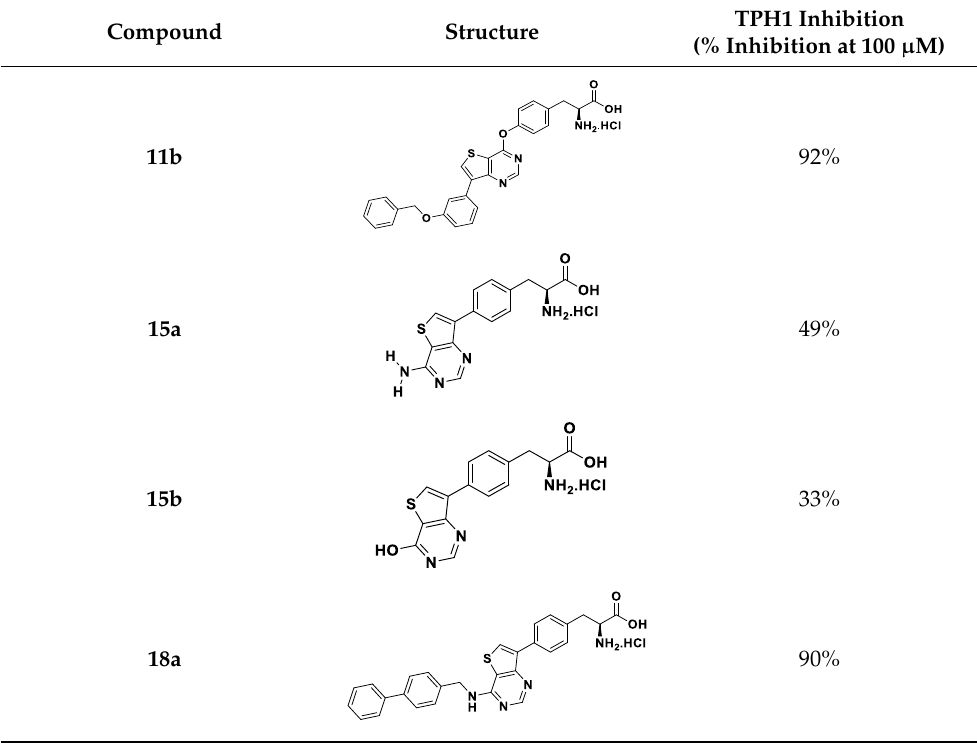
Figure 2. Binding analysis of compound 11b: Predicted binding mode of compound 11b with TPH1. TPH1 is shown as ribbons, while compound 11b is represented by sticks. The inset ( left ) shows the binding of compound 11b to the substrate-binding pocket of TPH1. The zoomed-in view ( right ) highlights the hydrophobic tail of compound 11b binding at the exterior of the active site of TPH1 with weak interactions. The entrance of the active site of TPH1 is not occupied with compound 11b which is required for the effective inhibition of